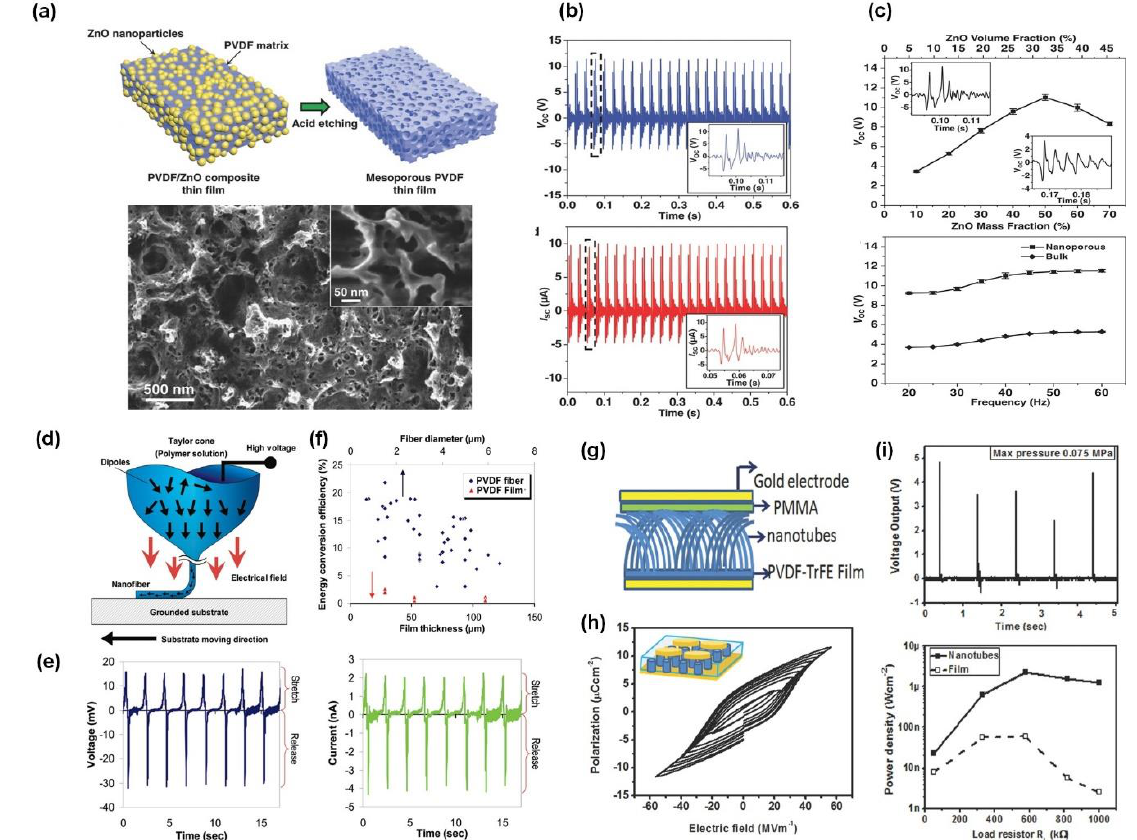
Figure 4. ( a ) Processing and structure of the mesoporous piezoelectric PVDF film, and the SEM image of the mesoporous PVDF film. ( b ) The voltage and current output of the mesoporous PVDF PENG under continuous surface oscillation. ( c ) Porosity-related voltage output. [91] Copyright 2014, WILEY-